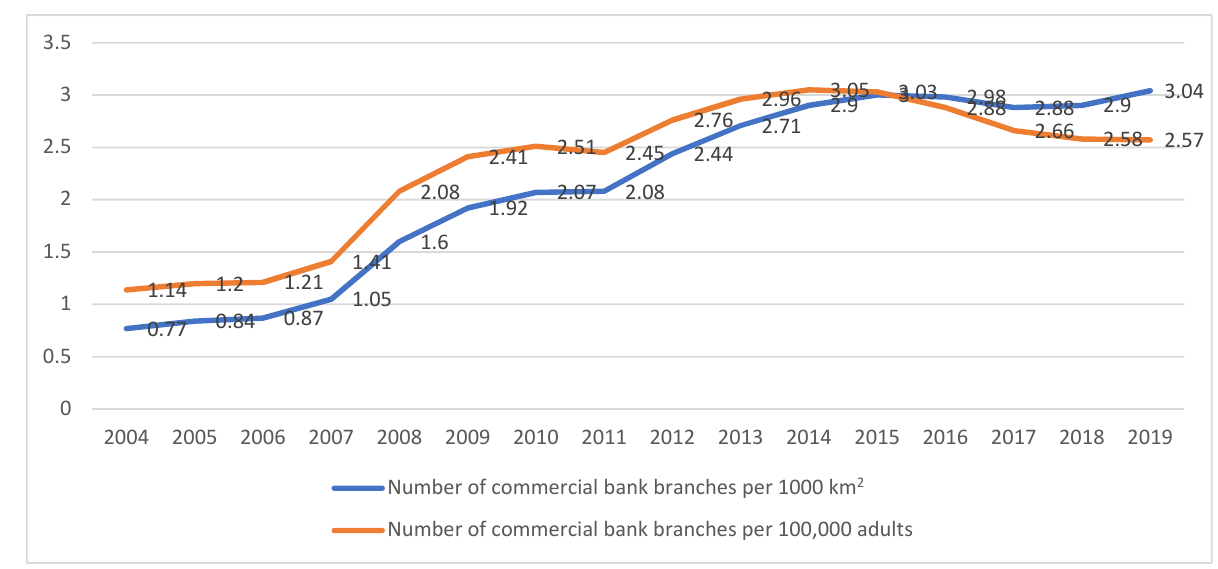
Figure 1. Penetration of bank branches and ATM per 1000 km 2 and per 100,000 adults. Overall, the penetration of ATMs per 1000 km 2 and the penetration of ATMs per 100,000 adults increased since 2004. ATMs per 1000 km 2 increased from less than 1 in 2004 to about 5 in 2019. Similarly, ATMs per 100,000 adults increased from 1 in 2004 to about 4 in 2019. The number of ATMs per 1000 km 2 surpassed the number of ATMs per 100,000 adults in 2015. The penetration of bank branches and ATMs per 1000 km 2 and per 100,000 adults is presented in Figure 2.